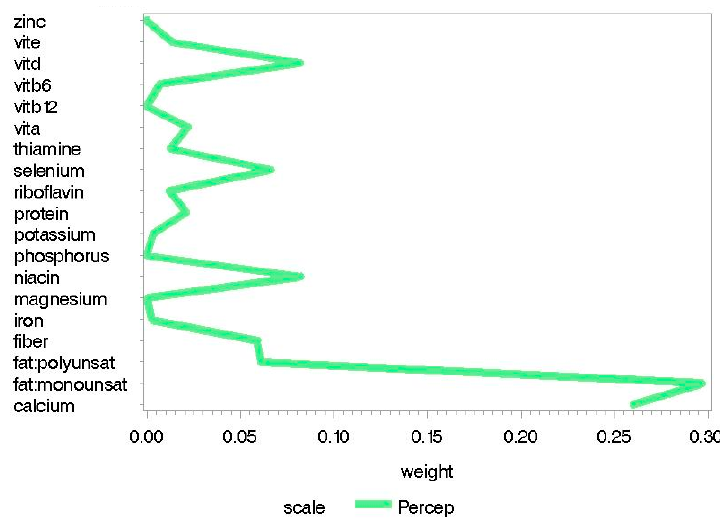
Figure 3. Weight plots for statistically significant scales from the childhood “good nutrition” index of dietary nutrition intake.